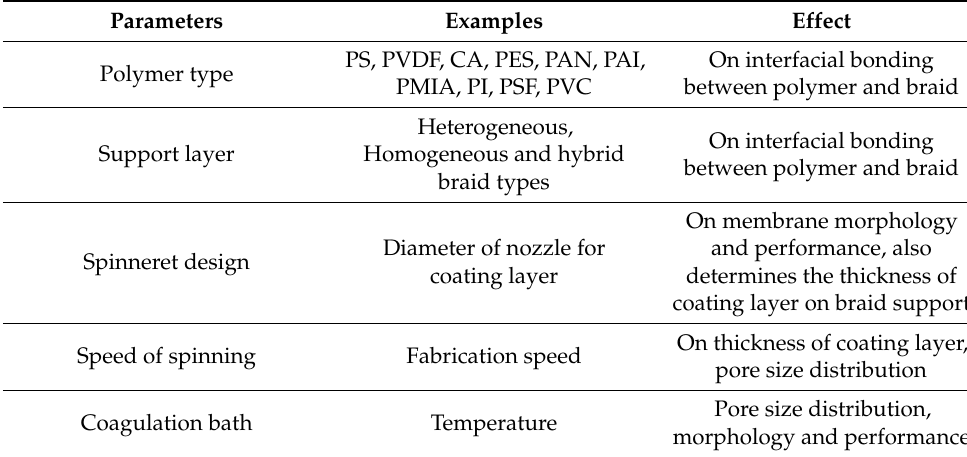
Table 7. BRHF membrane production parameters and their